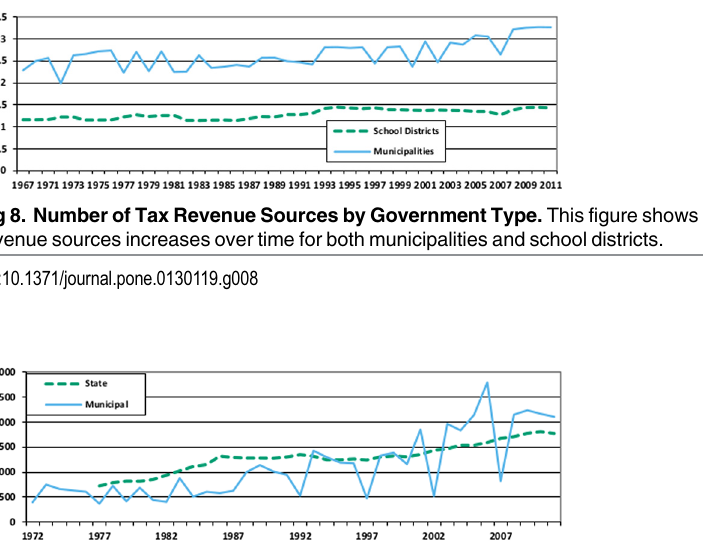
Fig 9. Real per Capita Debt by Government Type. This figure plots real, per-capita debt per person at both the state and municipal level.